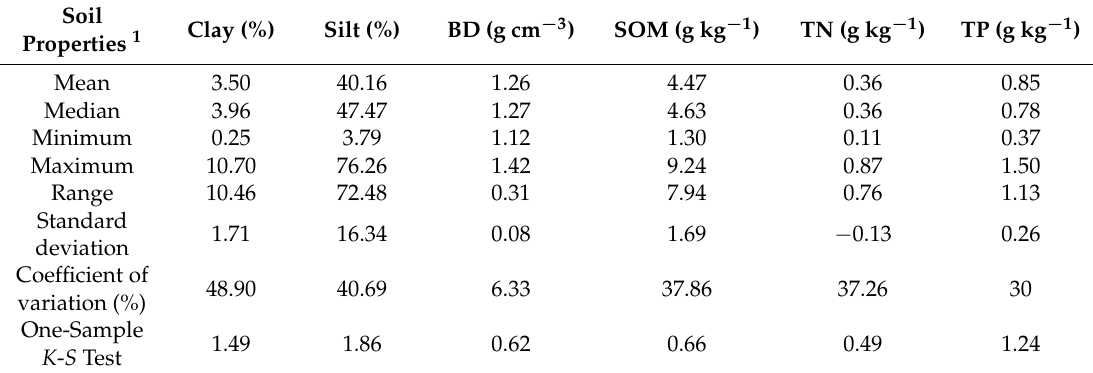
Table 1. Descriptive statistics for soil properties.